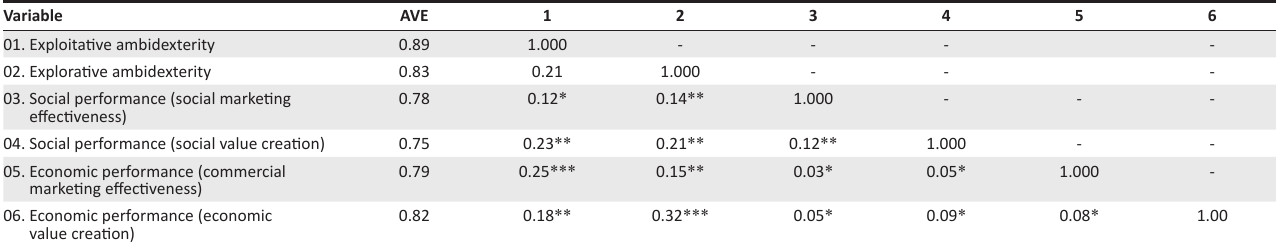
TABLE 2: Discriminant validity.